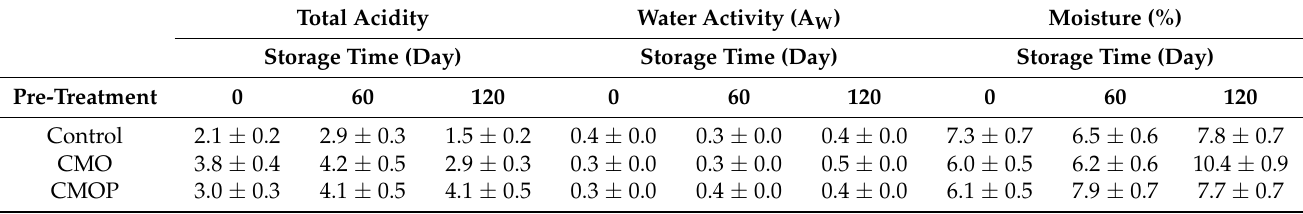
Table 7. Effect of the pre-treatment and storage time on the total acidity, A w and moisture of the untreated and pre-treated dried apple slices 1